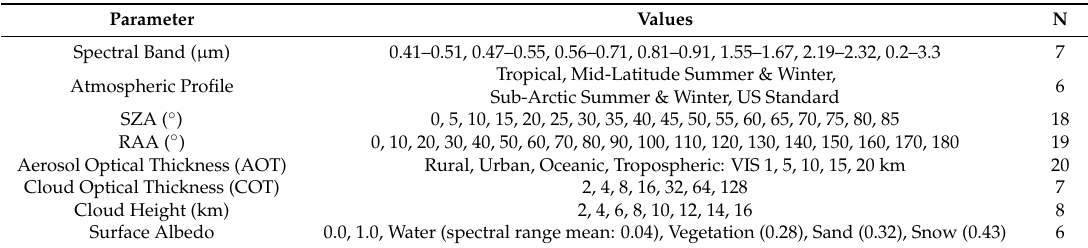
Table 1. Settings of the radiative transfer model for calculating the broadband albedo at the top of the